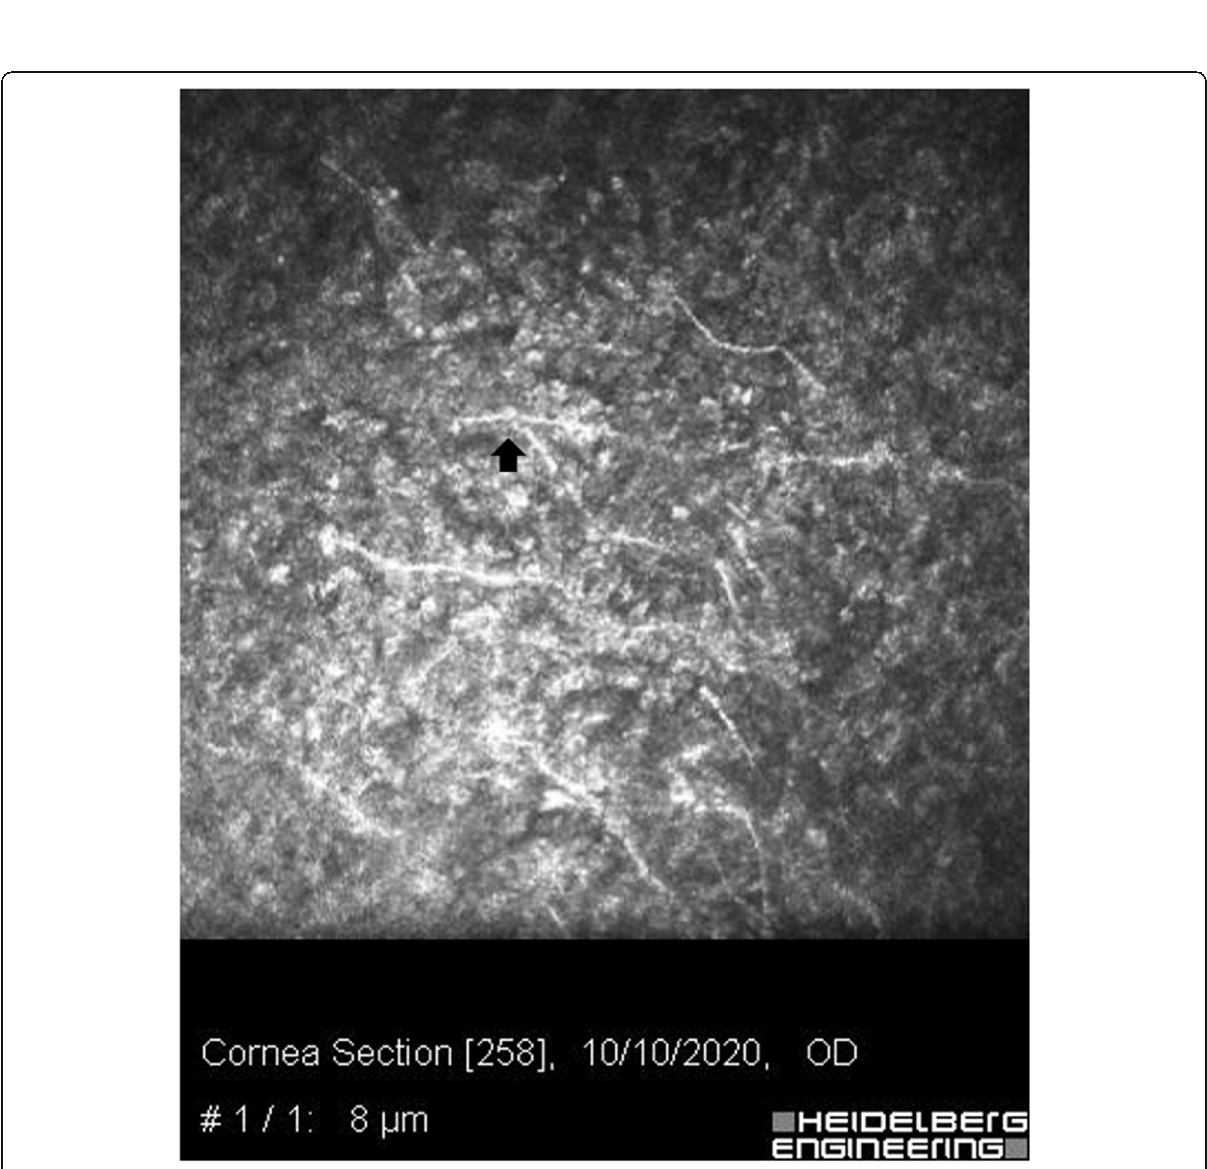
Fig. 2 In vivo confocal microscopy (IVCM) of the right eye. Hyphal structures (arrow) are branching and interlocking septate